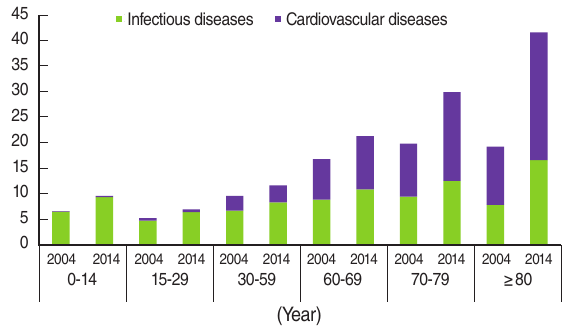
Figure 2. Hospitalization rates of infectious and cardiovascular diseases from 2004 to 2014 by age. Infectious Diseases